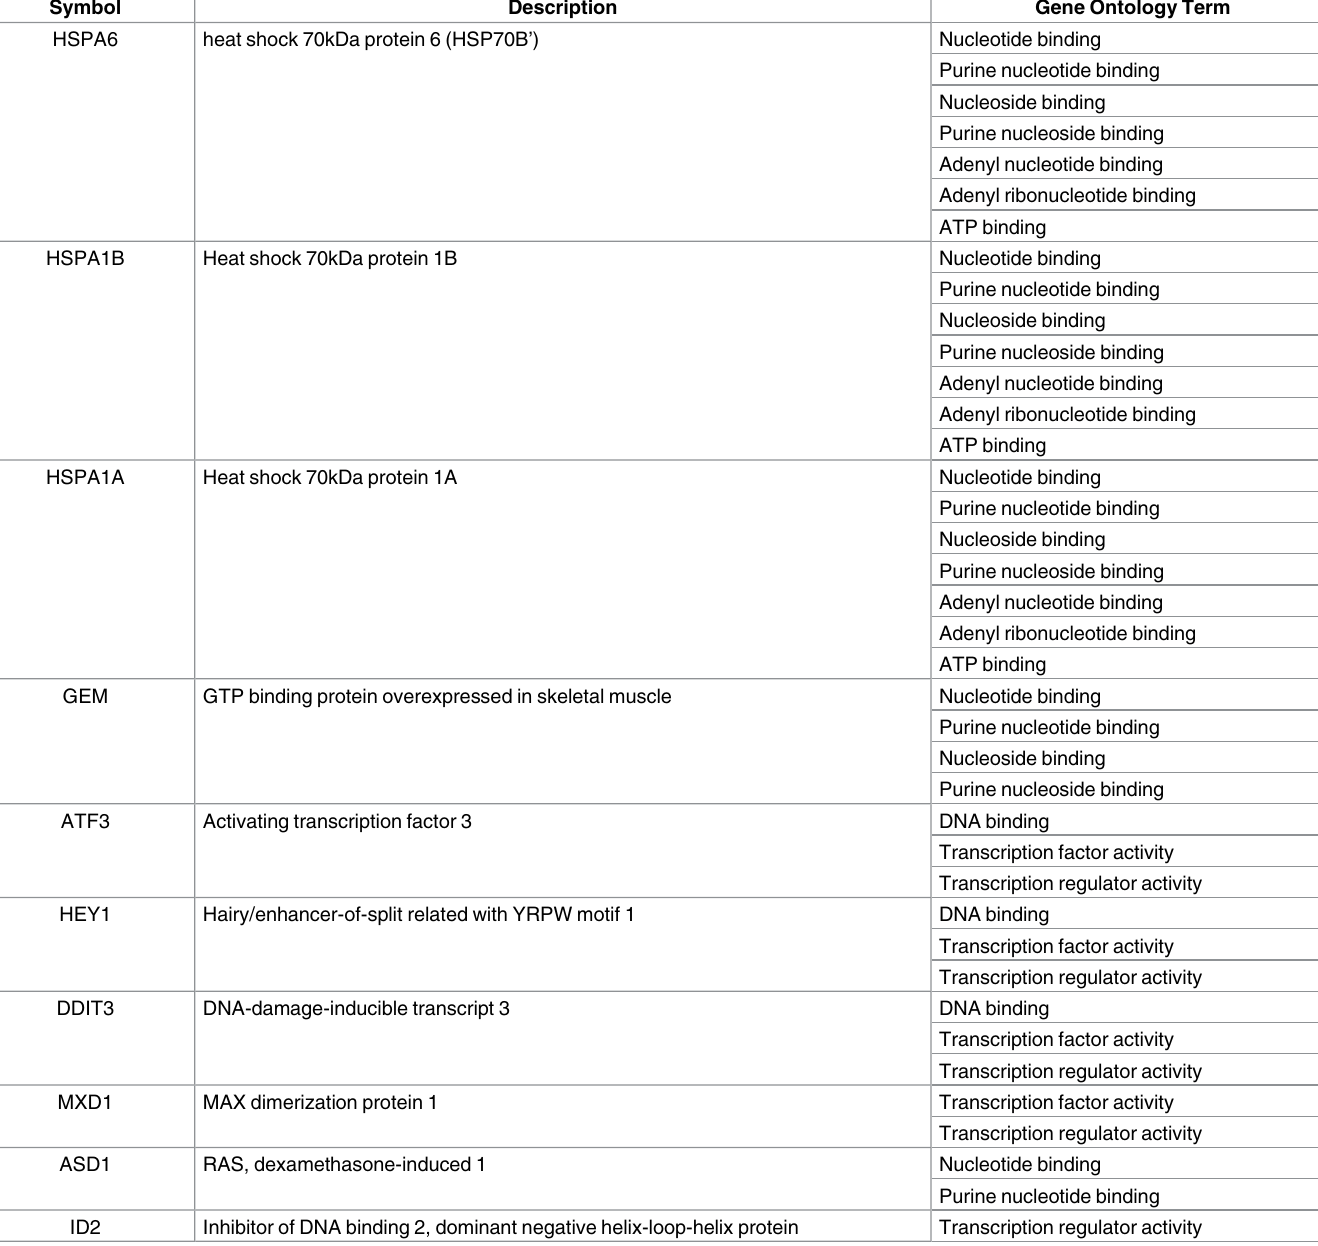
Table 3. The 10 most up-regulated genes found with MF analysis following GE